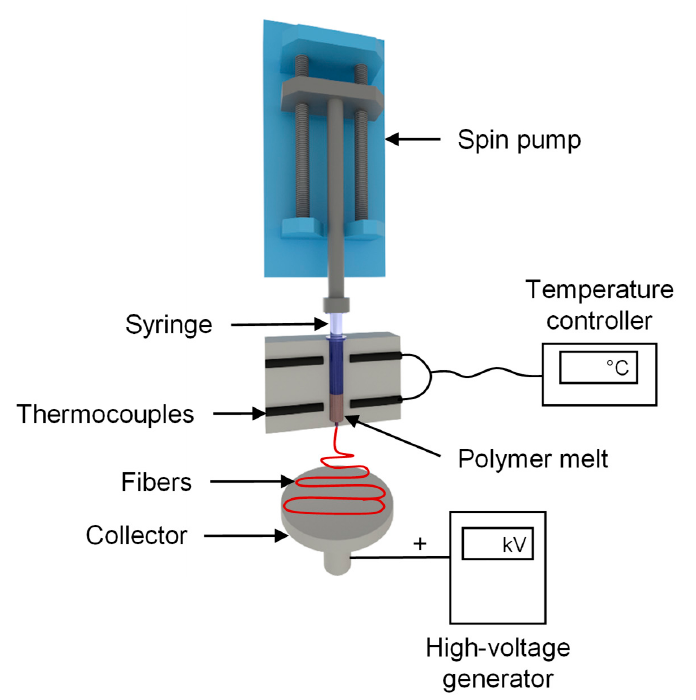
Figure 2. Laboratory single-fiber melt-electrospinning setup.